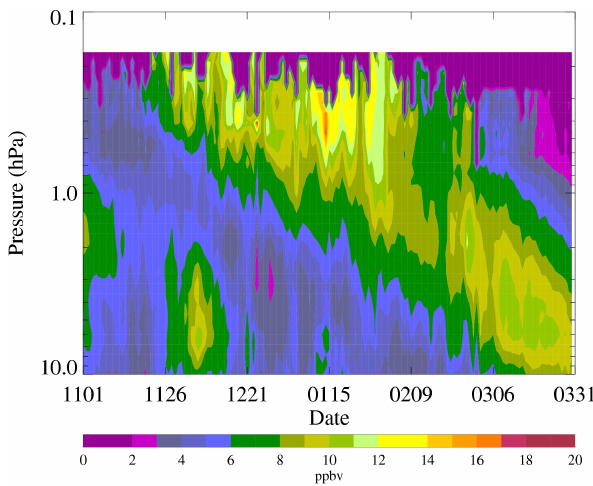
Fig. 11. Time series of LIMS V6 descending (or nighttime) NO 2 inppbv for latitudes > 74 ◦ N. The time span is from 1 Novem- ber 1978 (1101) to 31 March 1979 (0331). For those few days when no data were taken, the NO 2 values are averages from the adjacent days. Yellow colors are high values, while blue-to-magenta colors are low